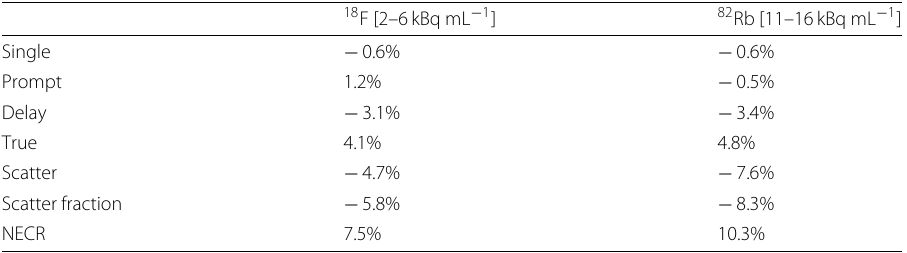
Table 3 Maximum relative differences between simulated and experimental data are reported for activity concentration ranges for clinical 18 F scans and 89 Rb cardiac perfusion scans